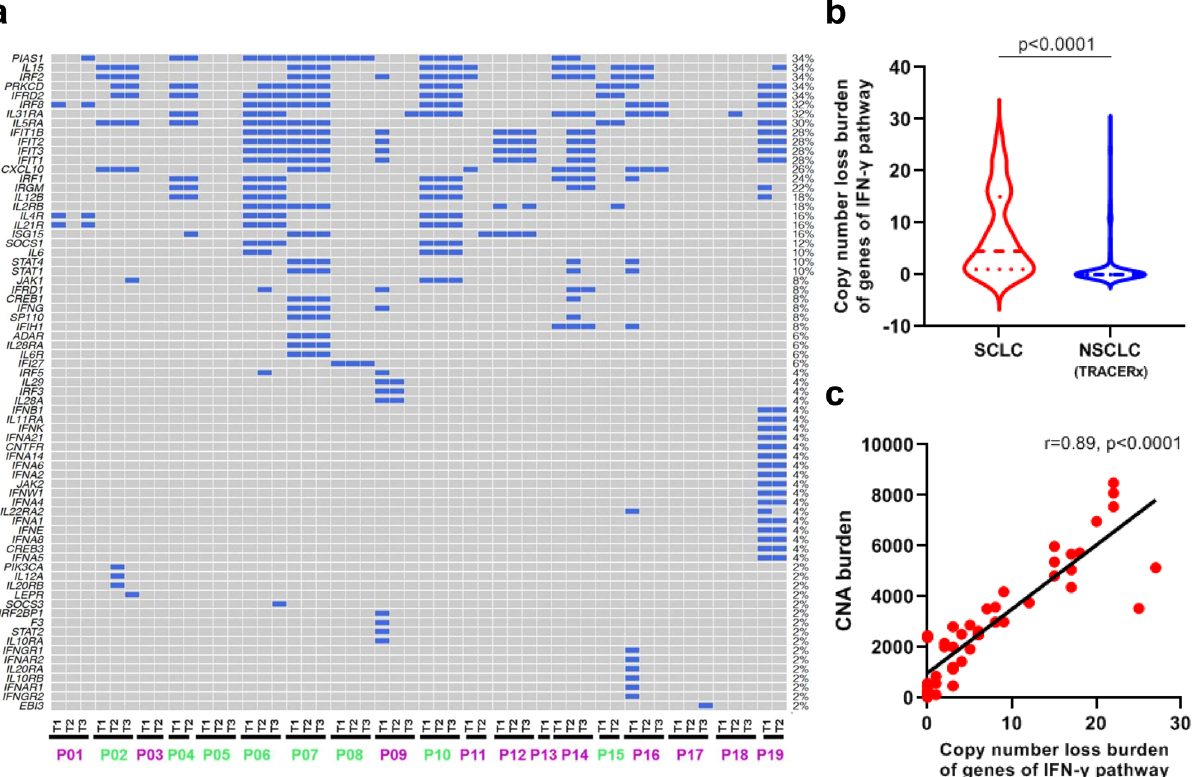
Fig. 6 Copy number loss of interferon gamma (IFN- γ ) pathway genes in small-cell lung cancer (SCLC) and comparison with non-small cell lung-cancer (NSCLC) tumors. a Copy number loss of IFN- γ pathway genes in 50 SCLC samples from 19 SCLC patients. Purple patient IDs = alive; Green patient IDs = deceased. b Copy-number loss burden of IFN- γ pathway genes in 50 SCLC samples (blue) versus 327 NSCLC samples (red) from TRACERx. c Correlation of copy number alteration (CNA) burden of IFN- γ pathway genes with overall CNA burden in SCLC ( n = 50). The difference of copy number loss burden of IFN- γ pathway genes between SCLC and NSCLC was evaluated using two-sided Mann – Whitney test. The correlation coef fi cient (r) of CNA burden of IFN- γ pathway genes with overall CNA burden was assessed by two-tailed Spearman ’ s rank-correlation test. Source data are provided as a Source Data fi higher than in NSCLCs from the TRACERx (9/19 versus. 36/90, some tumors (P01, P04, and P14 for example) had only a small p = 0.61) and the PROSPECT cohort (9/19 versus 60/216, proportion of predicted neoantigens binding to the lost allele, p = 0.11), although the difference did not reach statistical suggesting that other factors could have contributed to immune signi fi cance likely due to the small sample size. Among the evasion in these tumors. 21 samples with HLA LOH in this cohort of SCLC, a median of Taken together, these results suggest that there was once 52.7% (0 – 89.7%) of predicted neoantigens bound to the lost allele immune pressure during carcinogenesis of these SCLC. Loss of (Supplementary Fig. 21) supporting HLA LOH as one potential essential immune genes and HLA LOH could be common mechanism underlying immune evasion. On the other hand, genomic alterations underlying immune evasion. Eventually,